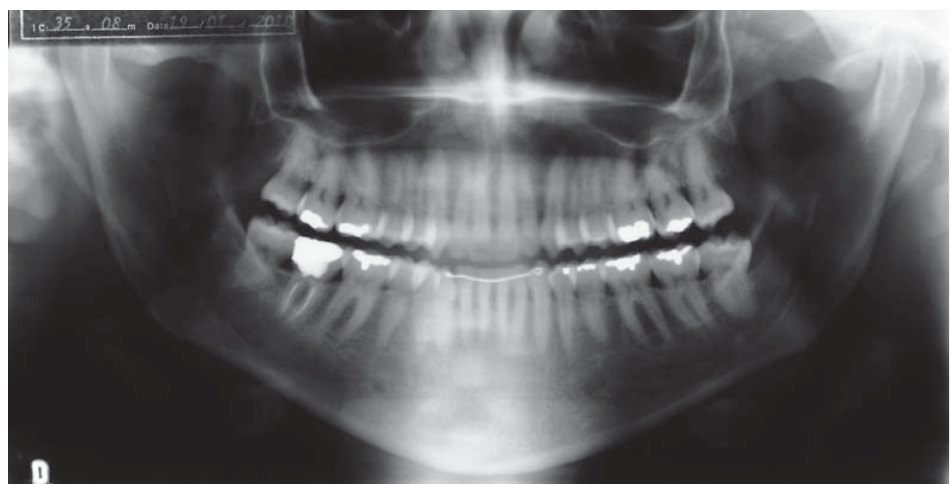
Figure 11- Panoramic